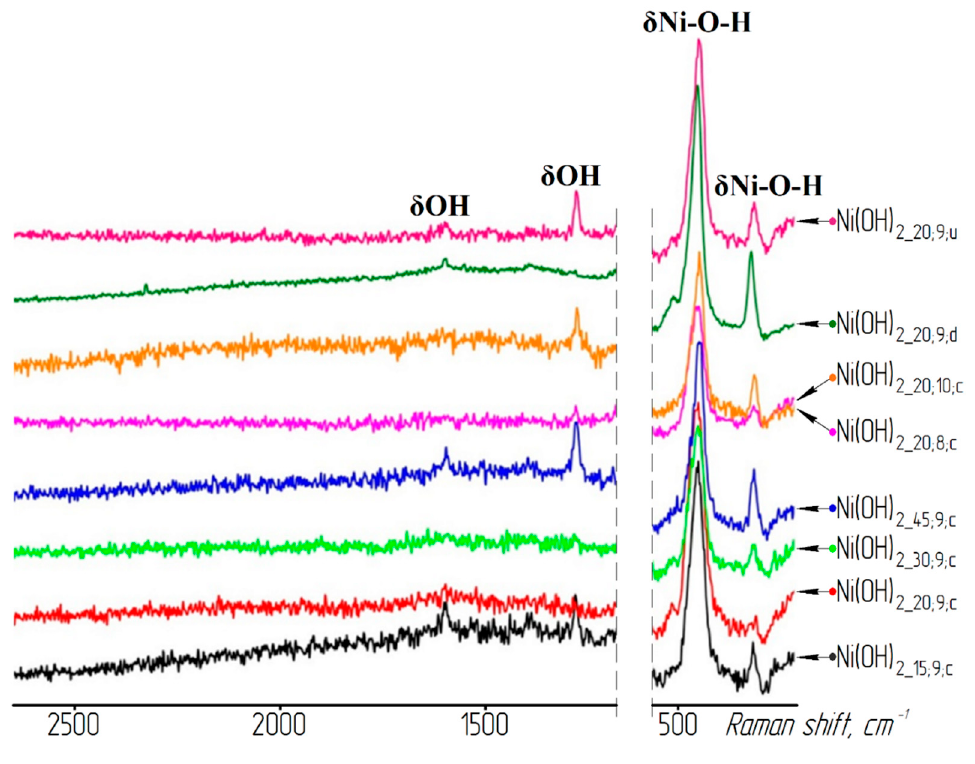
Figure 4. Fragments of the nickel hydroxide samples’ Raman spectra.